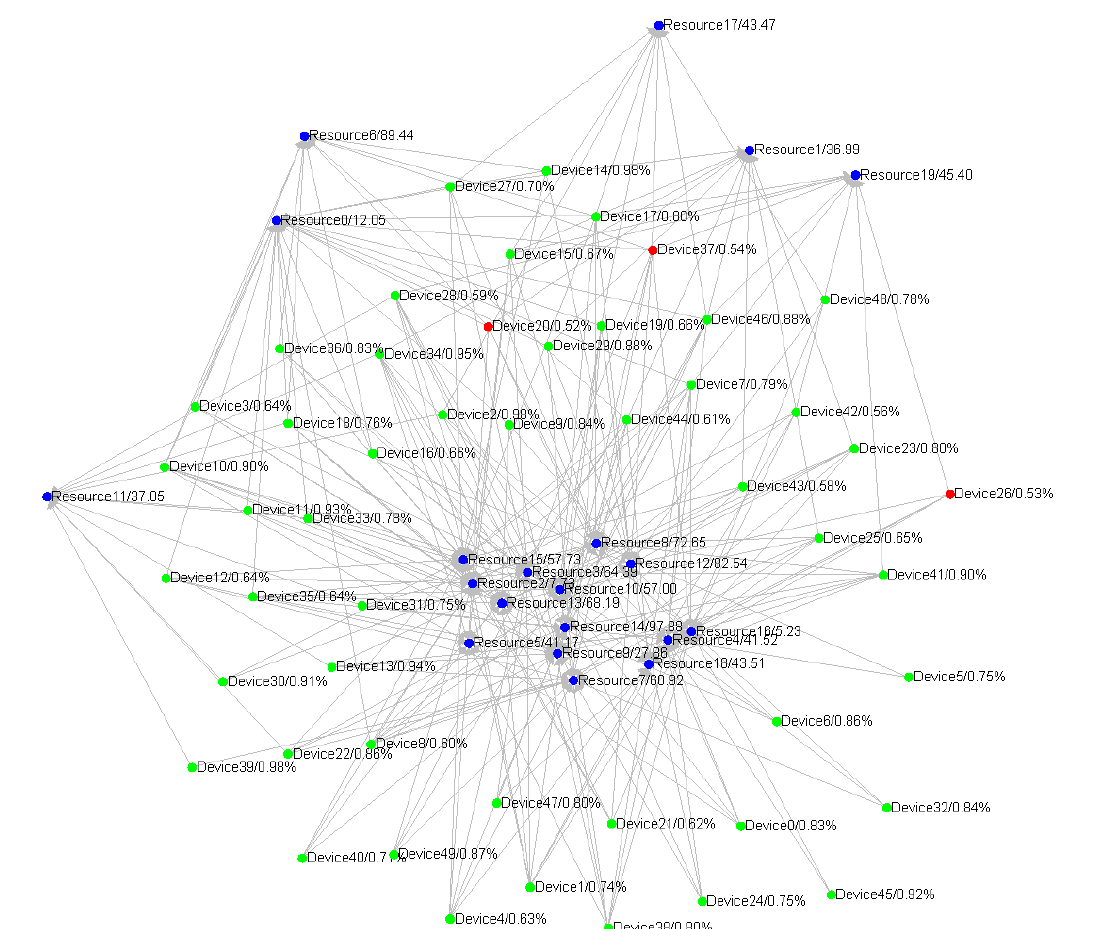
Figure 2. The visualised semantic-based belief network construction approach